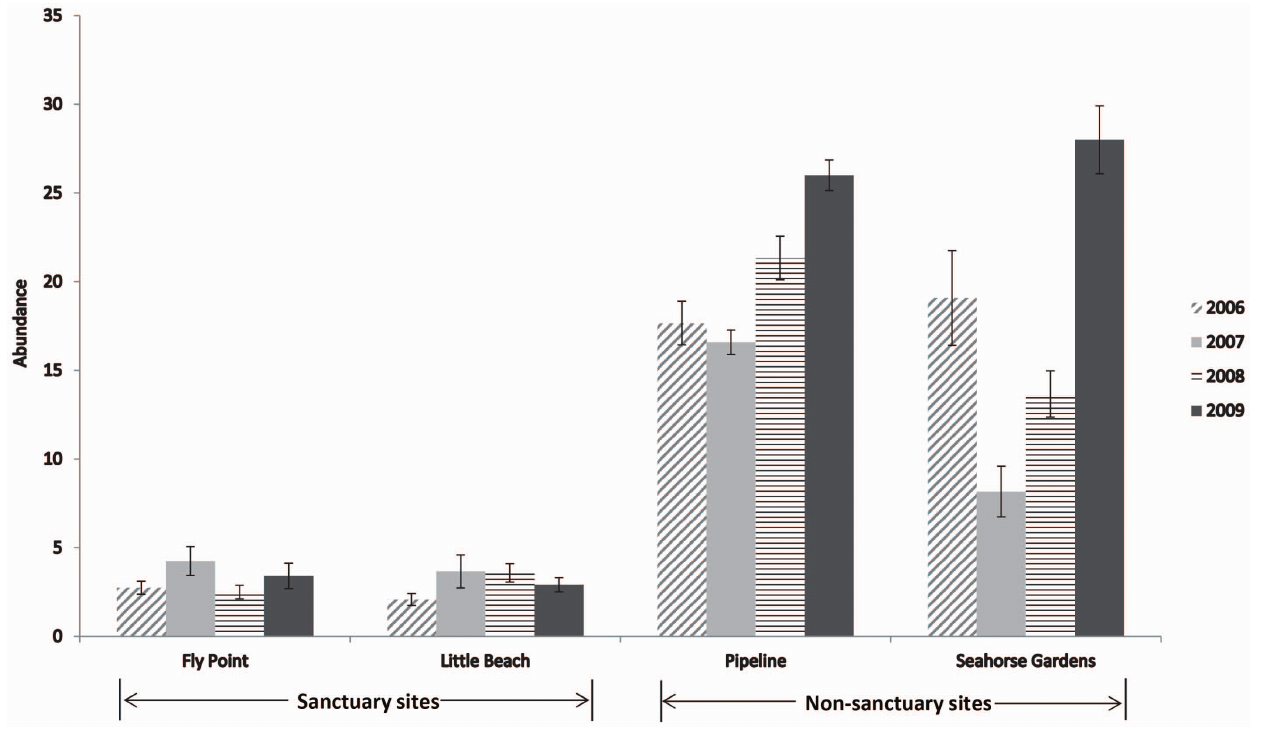
Figure 2. Mean monthly abundance of H.whitei ( ± S.E.) at four sites within Port Stephens for 2006–2009.